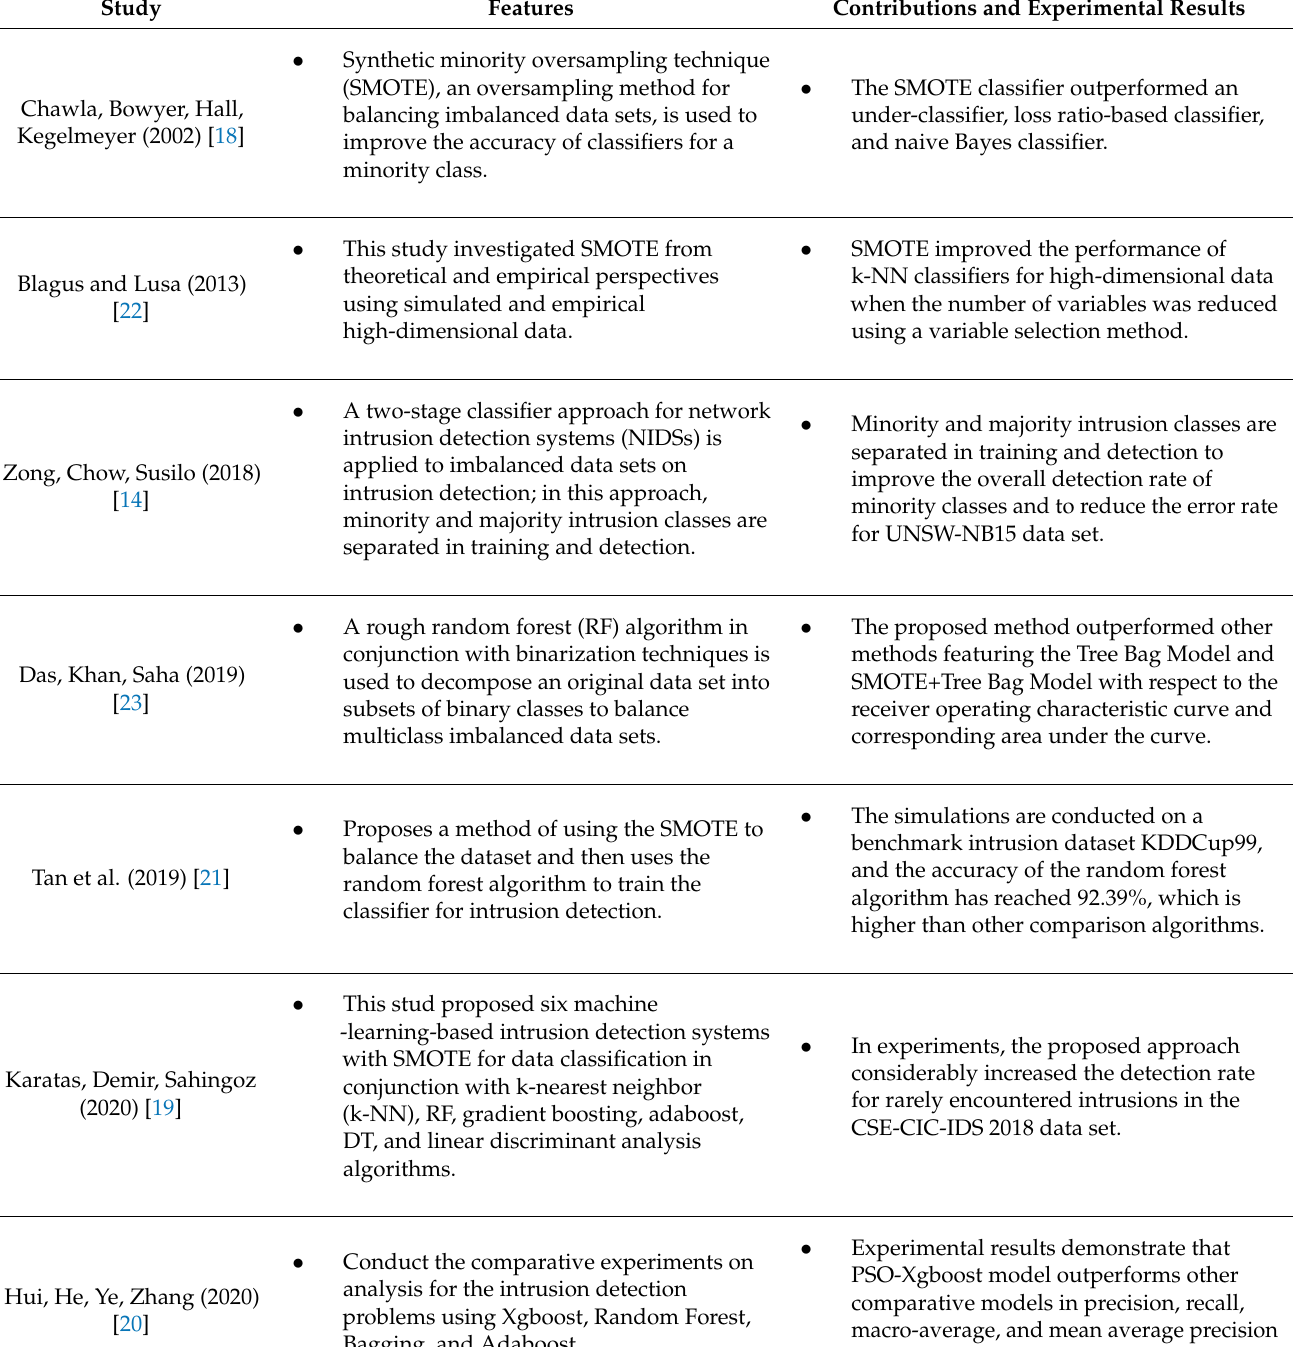
Table 3. SMOTE with machine learning approaches for network threat